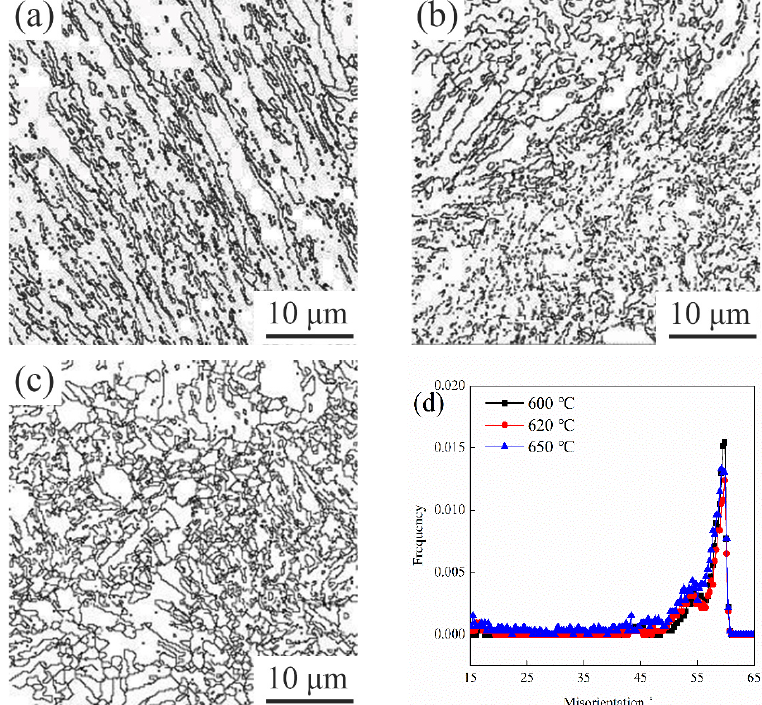
Figure 6. Boundary distribution maps with misorientation angle beyond 15 ◦ and misorientation angle distribution maps: ( a ) 600 ◦ C; ( b ) 620 ◦ C; ( c ) 650 ◦ C; ( d ) misorientation angle distribution maps.